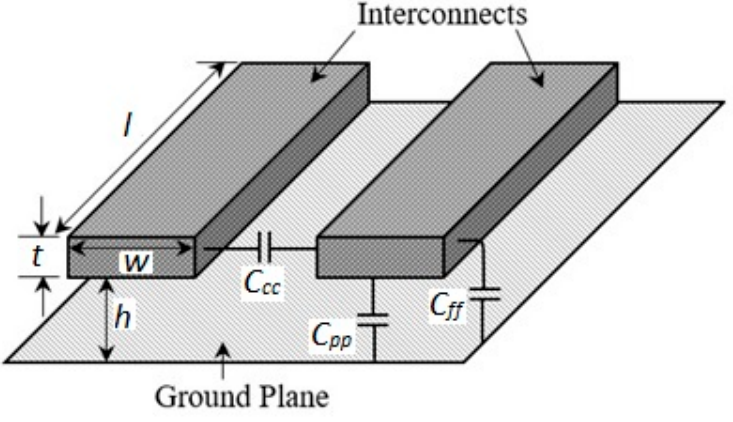
Figure 1. Schematic of on-chip interconnects parallel to the ground plane showing all parasitic capacitances.